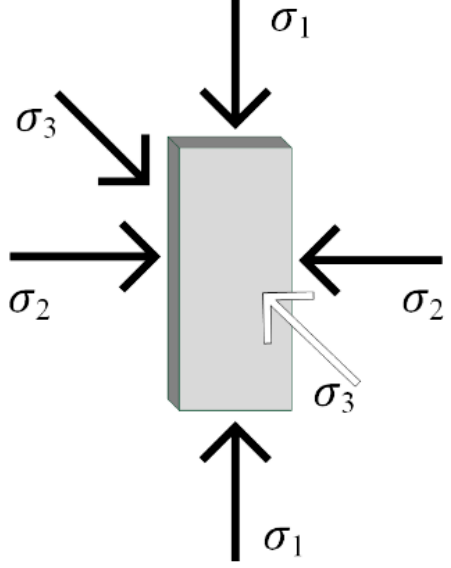
Figure 2. The rockburst physical simulation system.